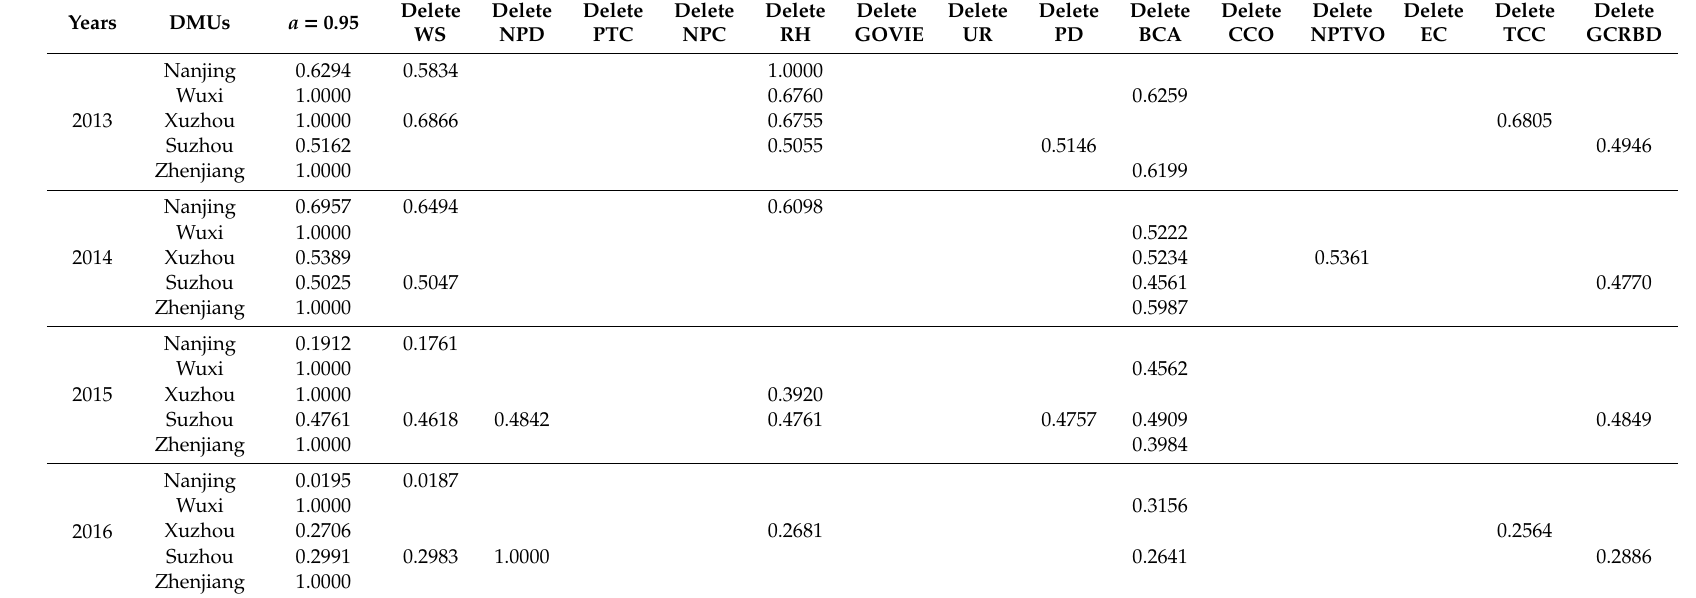
Table A13. The changes of stochastic e ffi ciency value by deleting single input variable in Southern Su ( α =